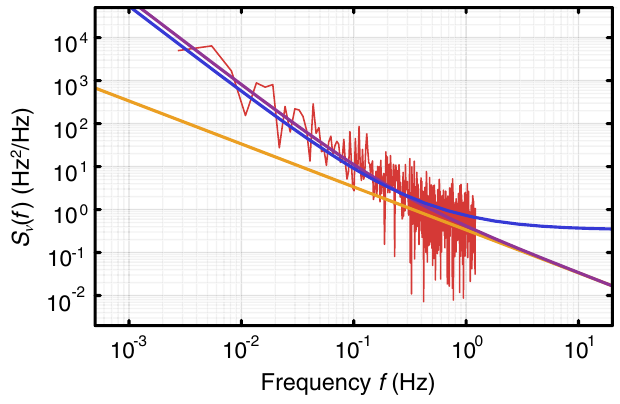
FIG. 5. Frequency noise spectrum of the clock laser. Power spectral density of the frequency noise of our clock laser measured from a beat signal with a reference laser over a 42- hour period (red trace). Our theoretical estimate of the thermal noise contribution is plotted in yellow. We also plot our best-case (purple) and worst-case (blue) models for total frequency noise, as used in Monte Carlo